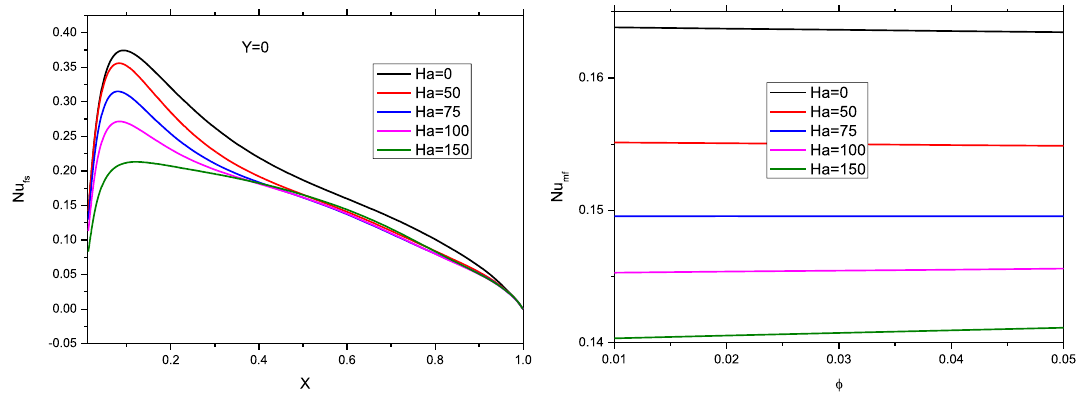
Fig. 9 Hartmann number for heat transfer profiles of the local Nusselt number of fluid phase (left) and average values (right) for TiO water Hybrid Nanofluid at Q = 1 , Da = 10 – 3 , Ri = 1 , Gr